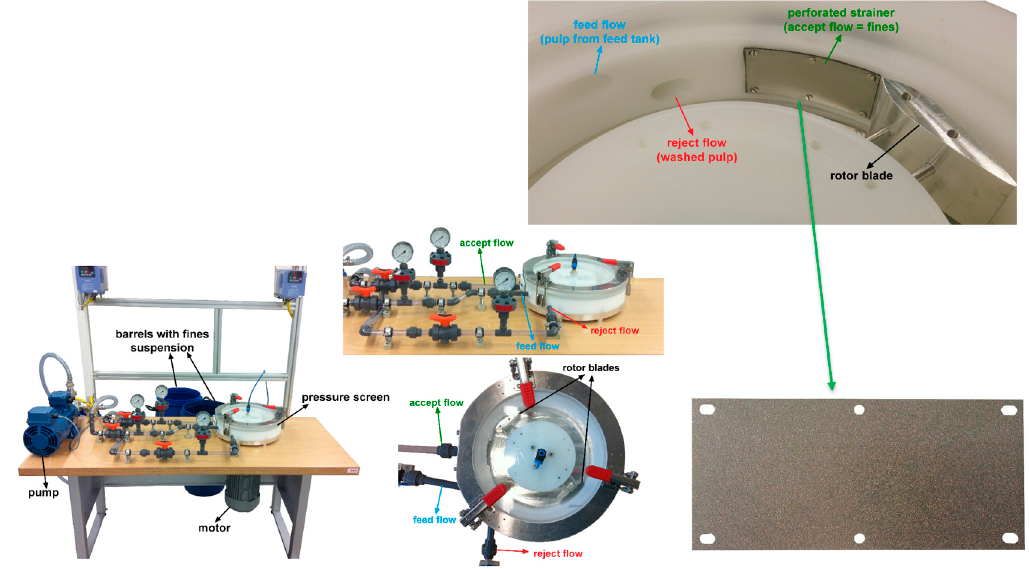
Figure 1. Pressure screen for separating fines from pulp.